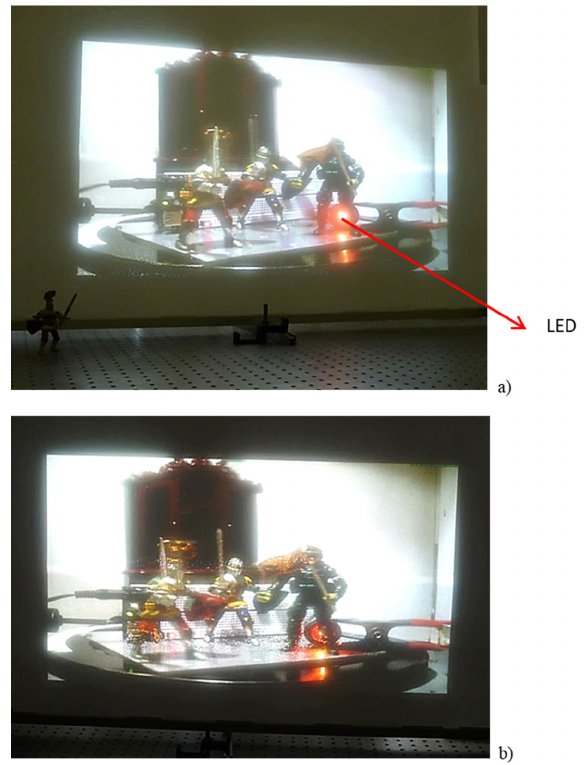
Figure 8. Images at different viewing angles: red LED is seen in the picture ( a ); LED light is covered with a foot of the warrior ( b ).